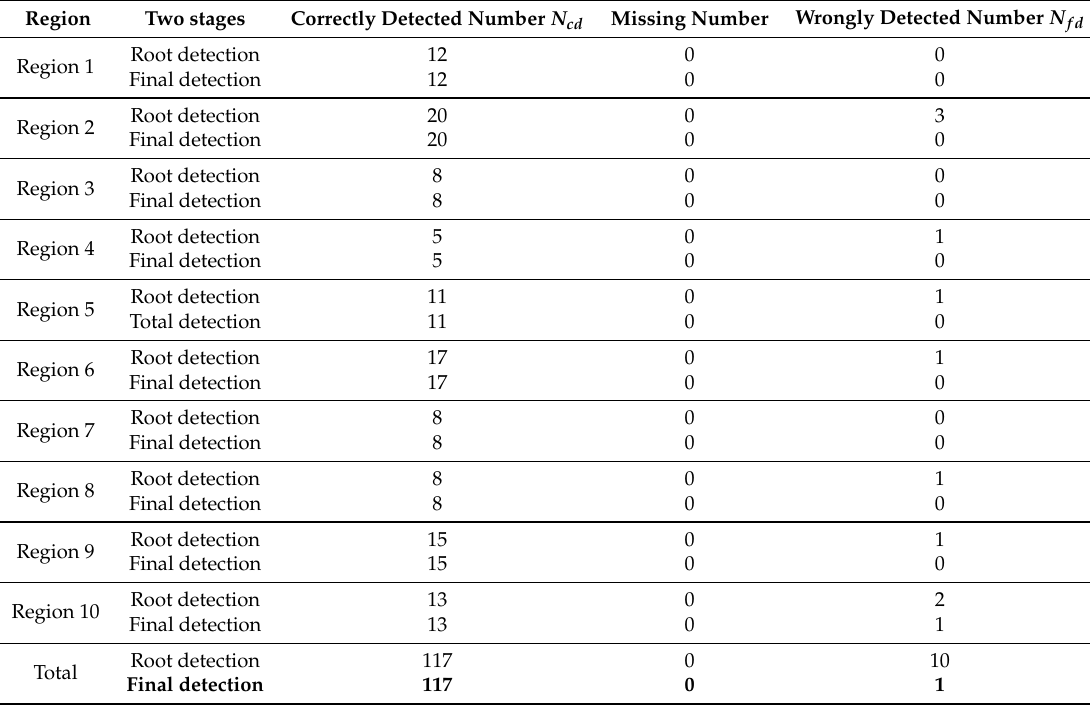
Figure 6. Detection result of the whole imagery. Table 3. Detection number of the proposed